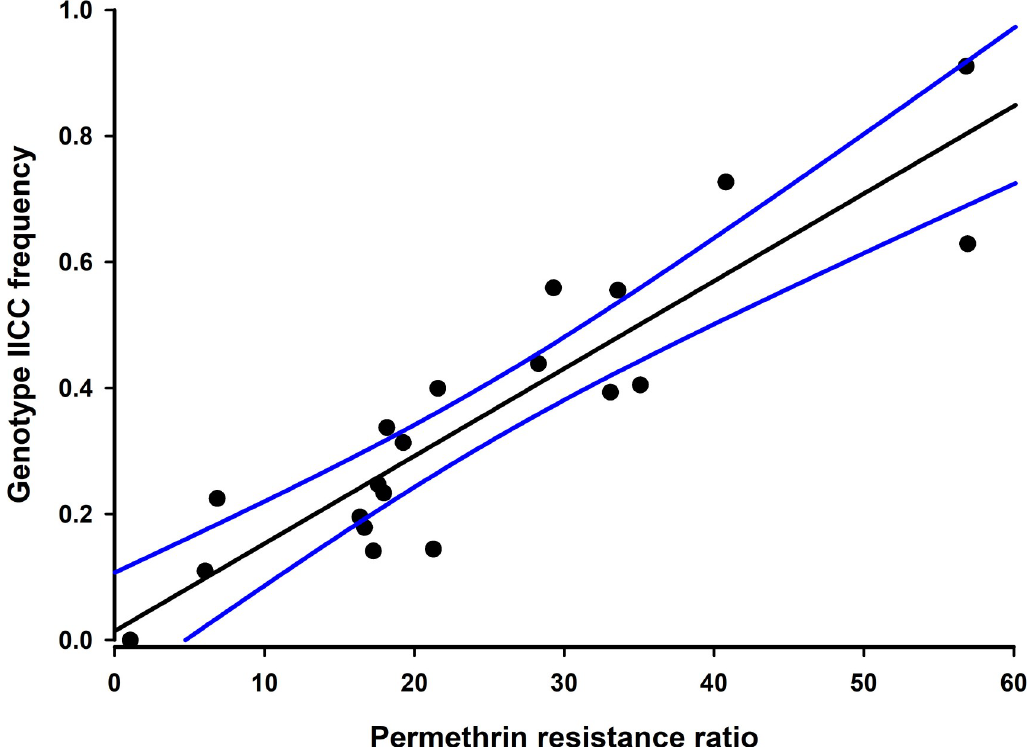
Fig 4. Regression of genotype IICC frequency to resistance ratio. Plot of RR versus IICC frequency indicates a strong correlation between the two factors (Pearson correlation coefficient ρ = 0.905). Comparison of RR to other genotypes did not indicate a strong